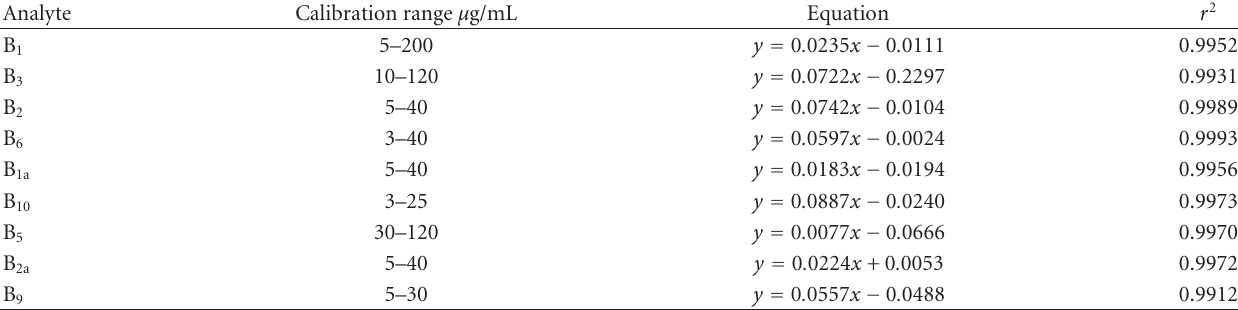
Table 2: Method linearity data.